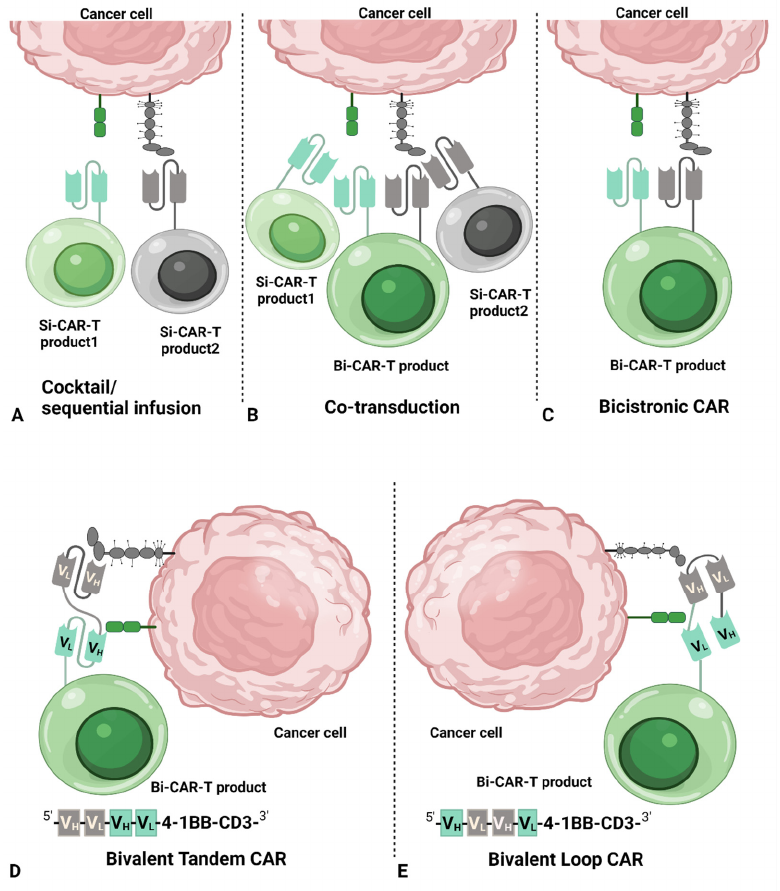
Figure 1. Illustration of dual-targeting CAR T-cell strategies. Dual-targeting CAR T-cell therapy is a therapeutic strategy to identify two tumor-associated antigens on cancer cells, which can be categorized into five dual CAR strategies. ( A ) Cocktail/sequential infusion of two Si-CAR T-cell products individually transduced with two different vectors. ( B ) A pool of two Si-CAR T-cell products and one Bi-CAR T-cell product by co-transductions of two vectors each encoding one individual CAR. ( C ) one Bi-CAR T-cell product produced by transduction of a bicistronic vector to introduce two separate CARs with one antigen-binding domain per CAR. ( D , E ) One Bi-CAR T-cell product expressing one bivalent CAR with two antigen-binding domains. Bivalent CAR can be categorized into two different structures by placing the V L and V H of scFv in different order, i.e., with V L -V H of one scFv directly linked to the V L -V H of the other scFv defined as bivalent tandem CAR ( D ) or with V L -V H of one scFv separated by the V L -V H of the other scFv defined as bivalent loop CAR ( E ). Illustration was created with BioRender.com. Abbreviations: Bi-CAR-T, bispecific chimeric antigen receptor T-cell; CAR, chimeric antigen receptor; scFv, single-chain variable fragments; Si-CAR-T, single-targeted chimeric antigen receptor T-cell; V H , variable heavy chain; V L , variable light